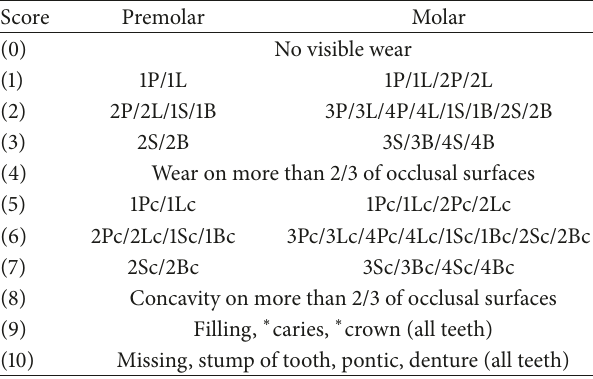
Table 2: Modified Kim’s index to score the teeth wear